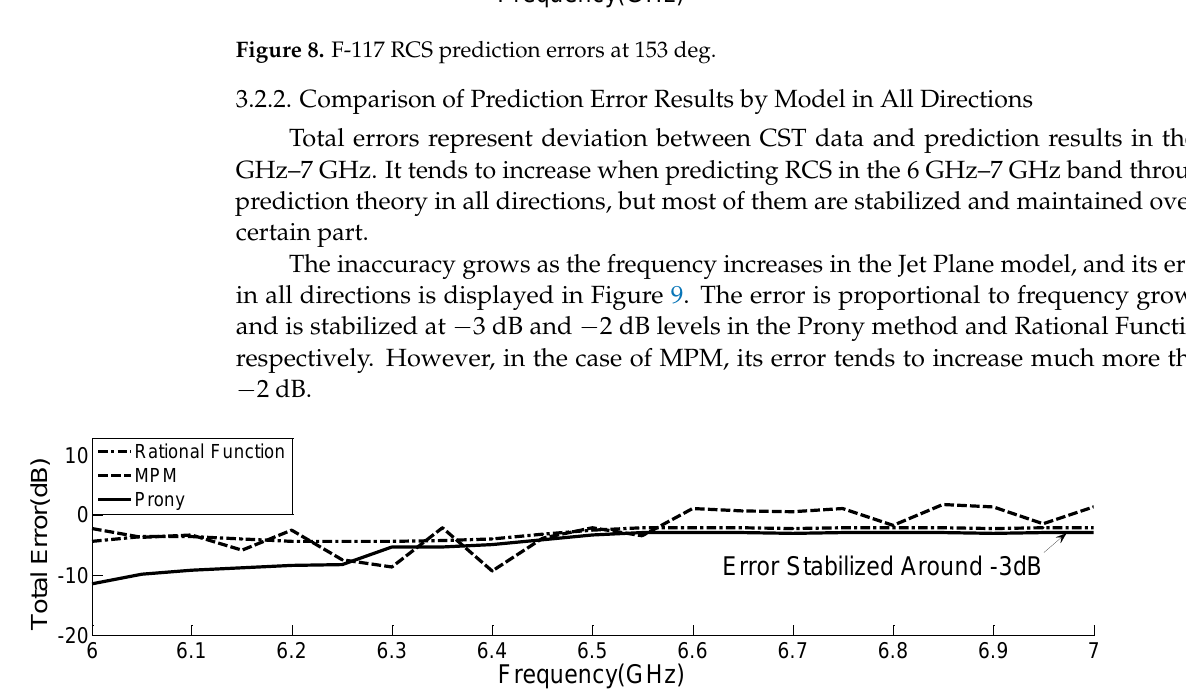
Figure 9. Jet Plane Prediction error results in all directions.